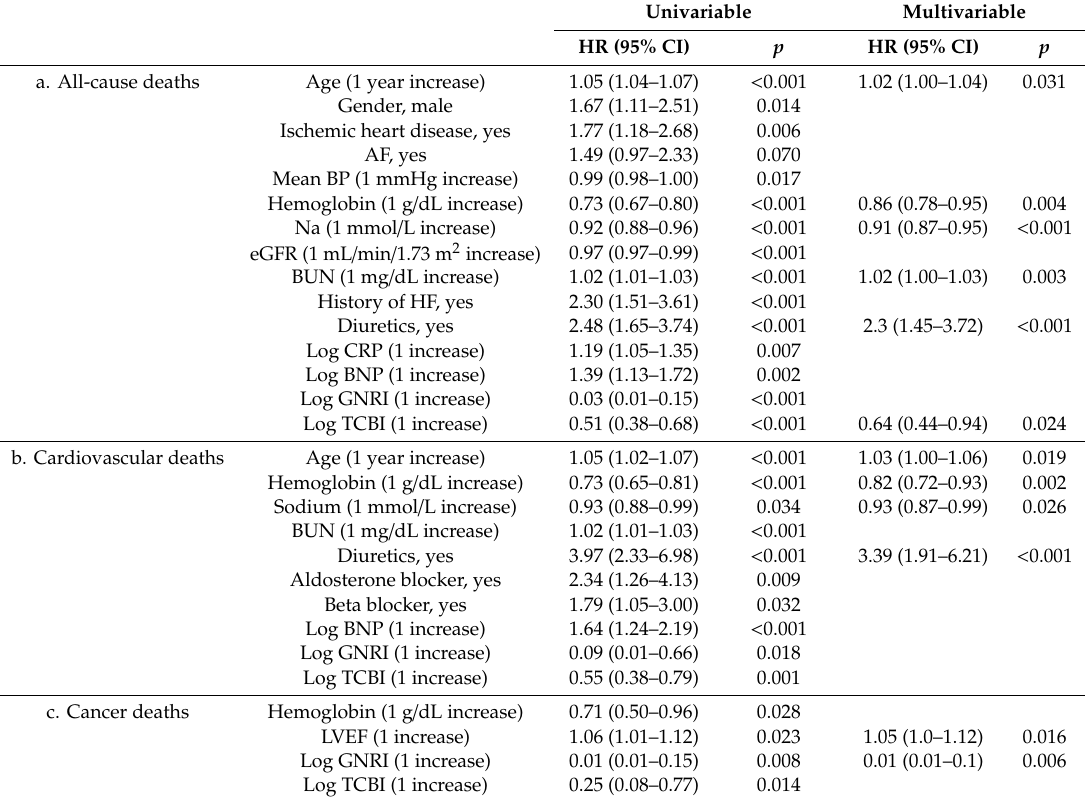
Figure 2. The correlation between TCBI and Geriatric Nutritional Risk Index (GNRI). TCBI was mildly correlated with GNRI (correlation coefficient = 0.287, 95% confidential interval (CI) 0.191–0.378, p < 0.0001). Table 2. Results of univariable analysis and final model of multivariable analysis using Cox proportional hazard analysis of all-cause (a), cardiovascular (b), and cancer deaths